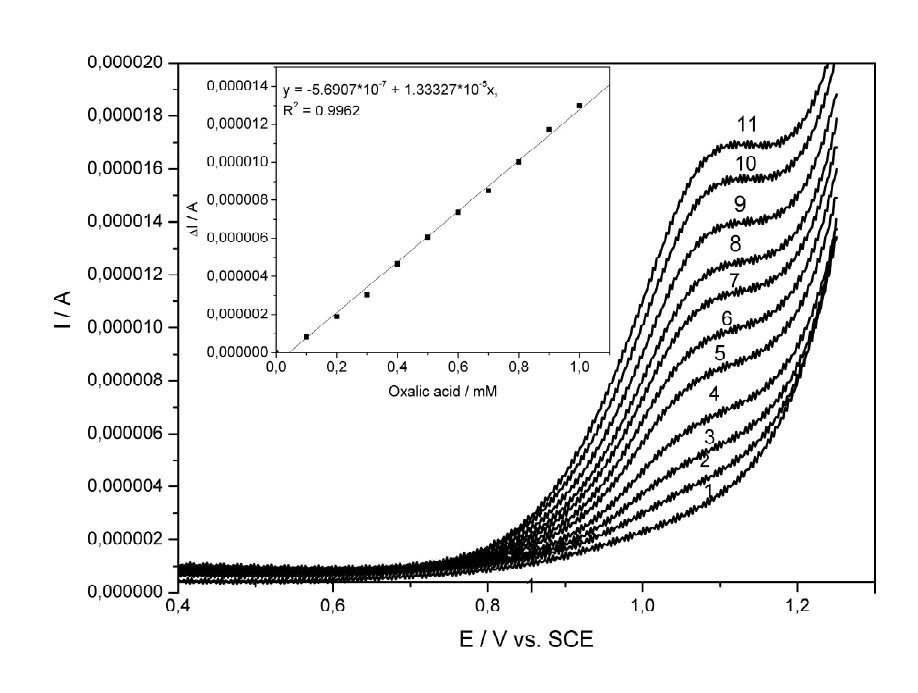
Figure 5. Linear voltammograms of EG-PS in the presence of oxalic acid concentrations:1-0 mM; 2-0.1 mM; 3-0.2 mM; 4-0.3 mM; 5-0.4 mM; 6-0.5 mM; 7-0.6 mM; 8-0.7 mM; 9-0.8 mM; 10-0.9 mM; 11-1 mM; potential scan rate0.05 Vs -1 ; supporting electrolyte 0.1 M Na